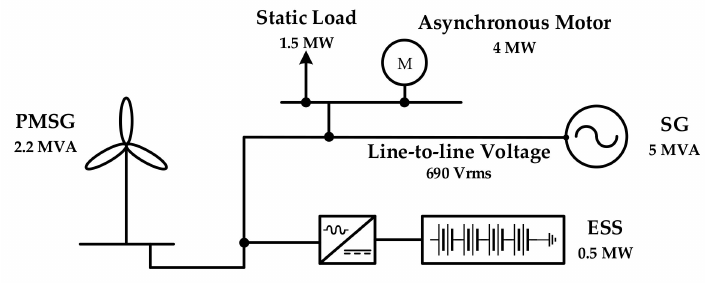
Figure 7. A single-line-diagram of the isolated microgrid